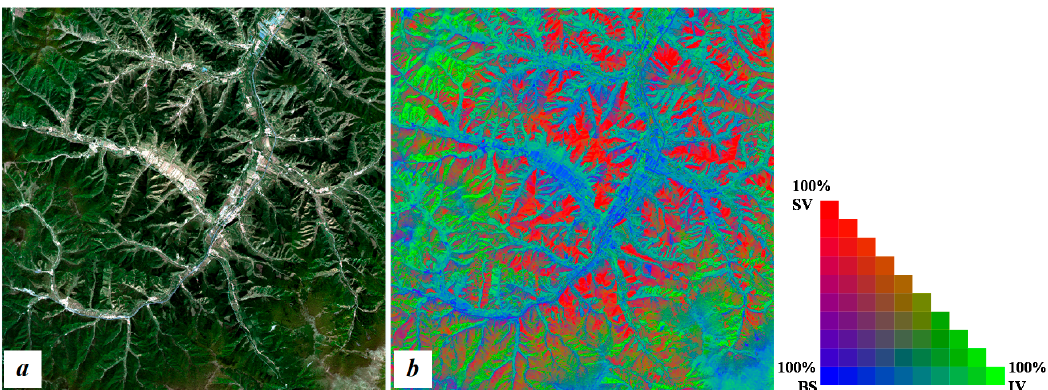
Figure 9. Result ( b ) of the illuminated / shaded vegetation fractional cover unmixing based on the NDCSI and BSI for the Sentinel-2A image, comparing to the processed standard reflectivity image of Sentinel-2A ( a ).